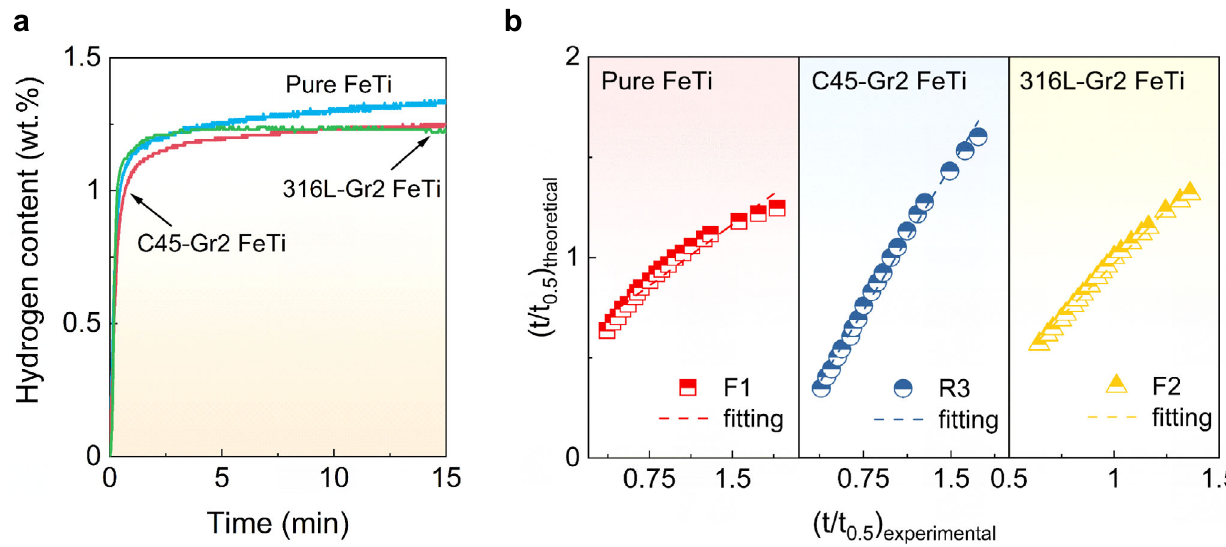
Fig. 5 Hydrogenation kinetic behaviors at 40 °C and under 65 bar of H 2 pressure of pure FeTi, C45-Gr2 FeTi, and 316L-Gr2 FeTi alloys. a Volumetric hydrogen capacities for hydrogenation of pure FeTi, C45 FeTi, and 316 L FeTi alloys. b corresponding kinetic modeling results of pure FeTi, C45-Gr2 FeTi, and 316L-Gr2 FeTi